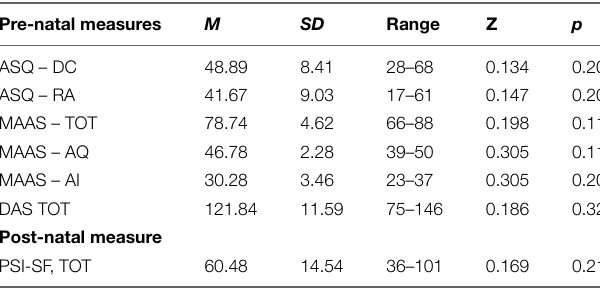
TABLE 2 | Descriptive statistics for the antenatal and postnatal